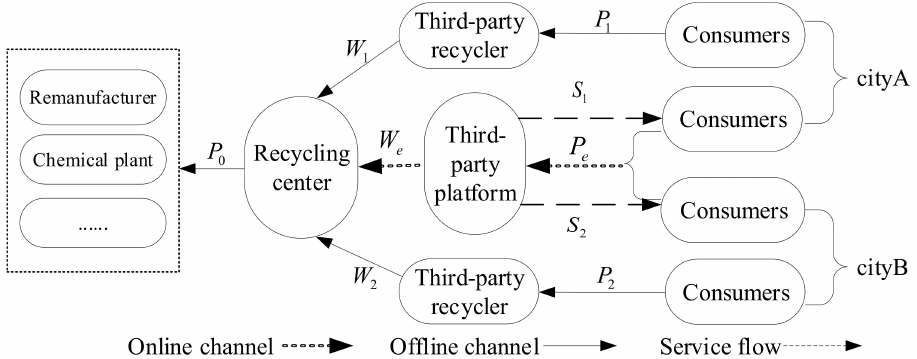
Figure 1. Depiction of the dual-channel reverse supply chain in multi-regional